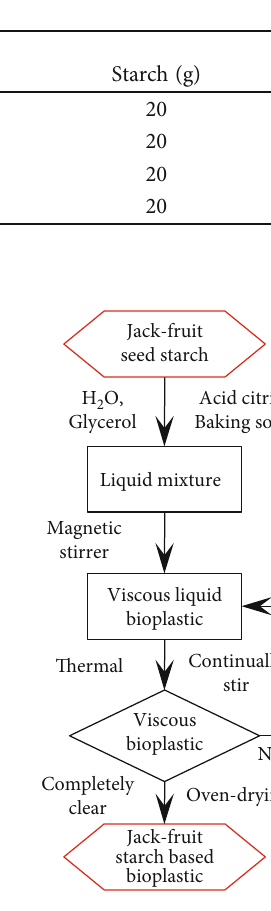
Figure 1: Flow diagram of bioplastic fabrication using jackfruit seed